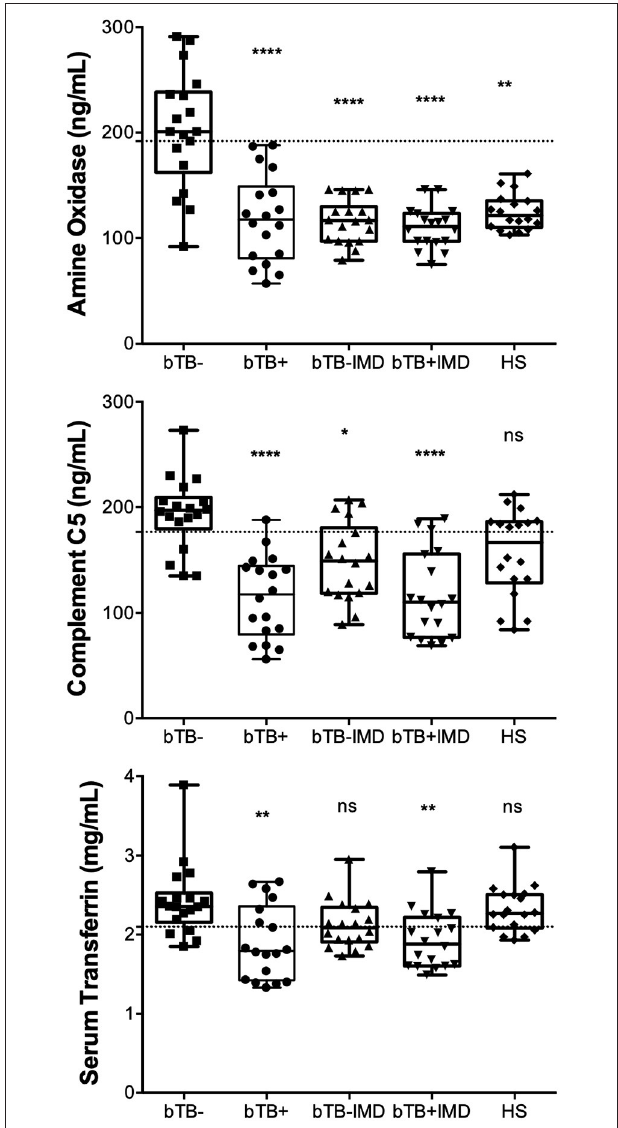
FIGURE 5 | Concentrations of AO, C5, and TF measured in clinical samples by ELISA tests exhibit significant efficacy in diagnosing bTB-resistant cattle. AO, C5, and TF were quantified by the in-house developed and standardized indirect sandwich ELISAs in serum samples (n = 18) of cattle from herds with endemic bTB, but without bTB (bTB-), cattle with bTB (bTB + ), cattle without bTB, and with any infectious or metabolic disease (bTB-IMD), cattle with bTB and with IMD, and healthy cattle (HS). Statistical analysis was performed by comparing the mean rank of each group of cattle against the mean rank of